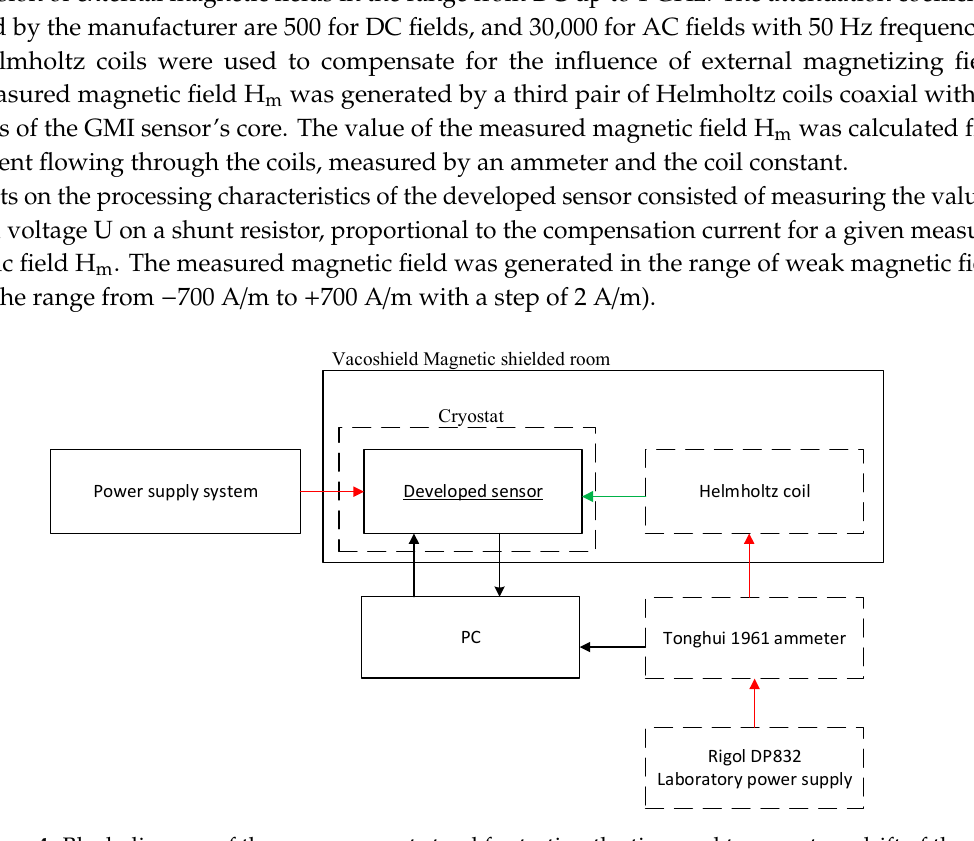
Figure 4. Block diagram of the measurement stand for testing the time and temperature drift of the proposed sensor.